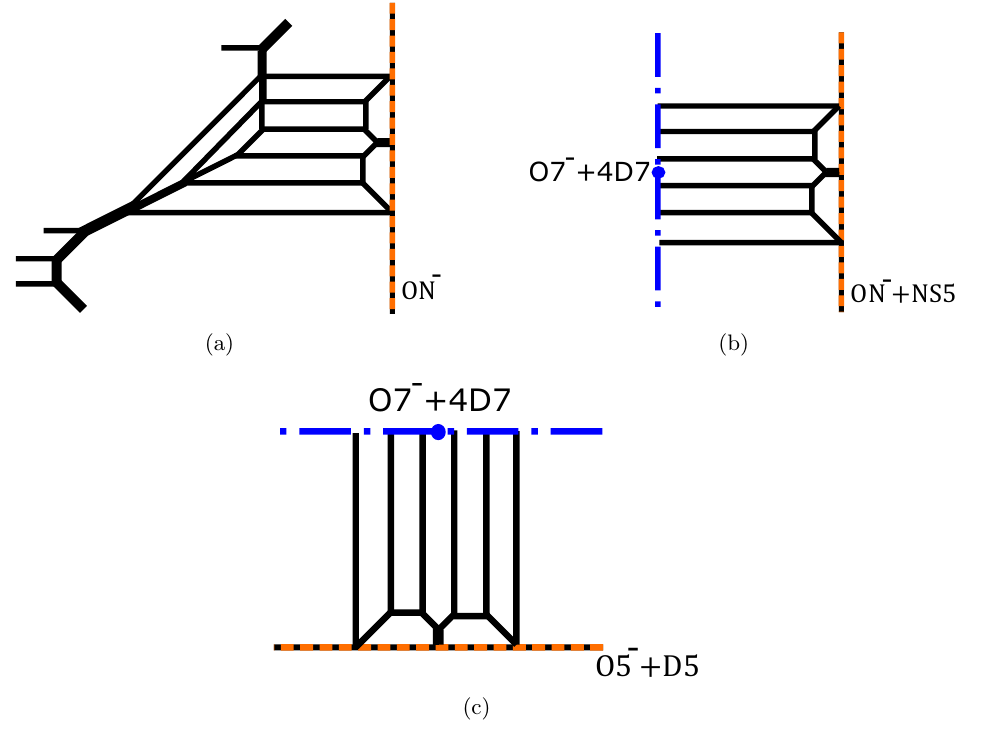
Figure 31 . (a) A diagram for the Sp(3) gauge theory with N TAS = 1 Higgsings the diagram in (cid:12)gure 21. (b) A Tao diagram from the diagram in (cid:12)gure 31(a).